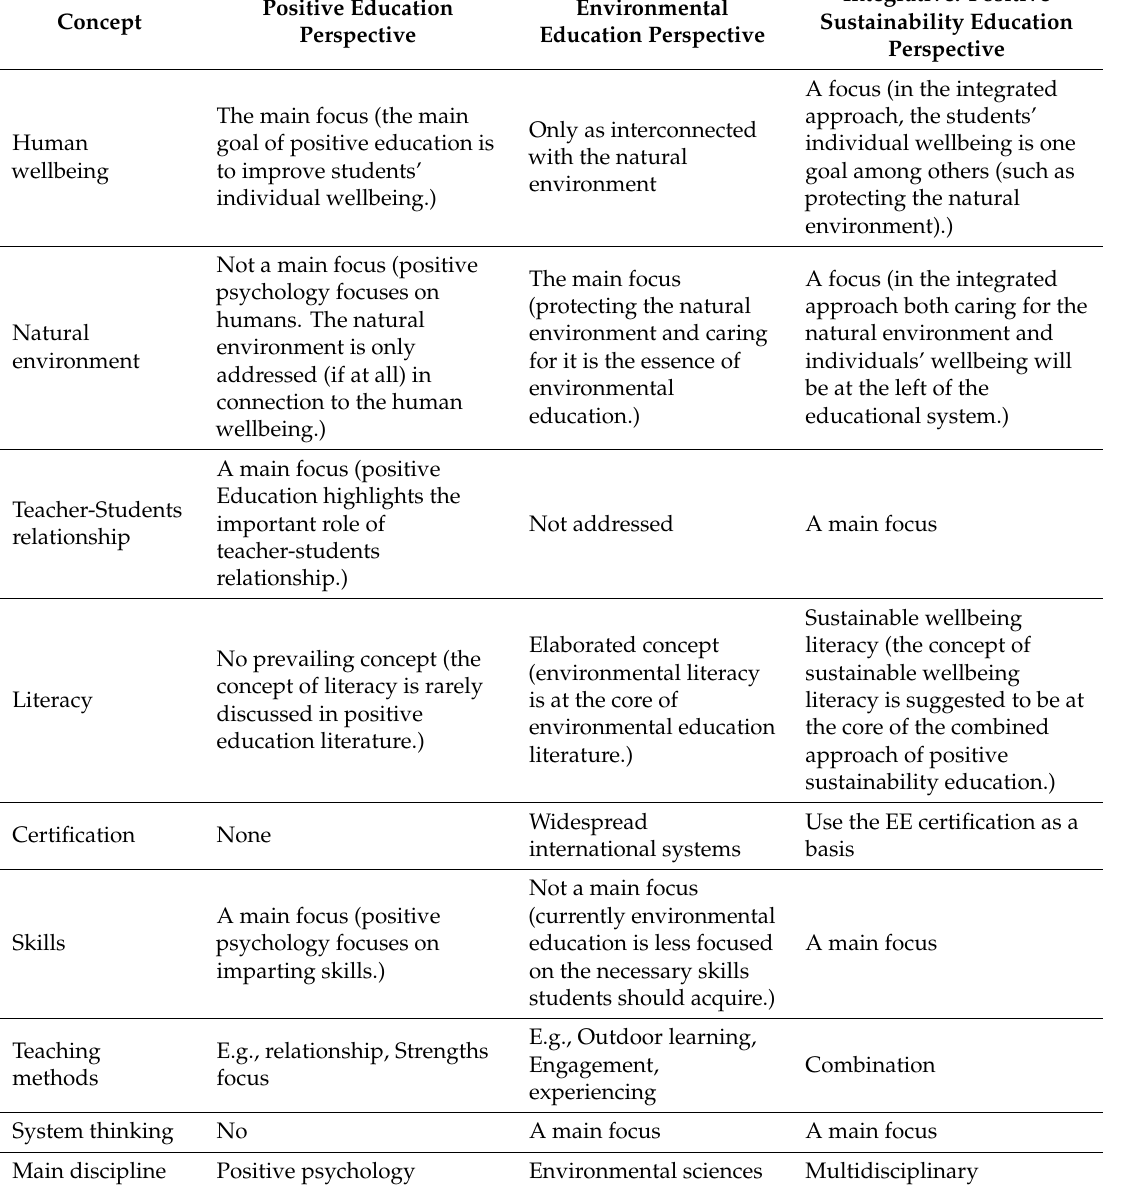
Table 1. Implementation of main concepts in positive education, environmental education, and the integrated positive sustainability